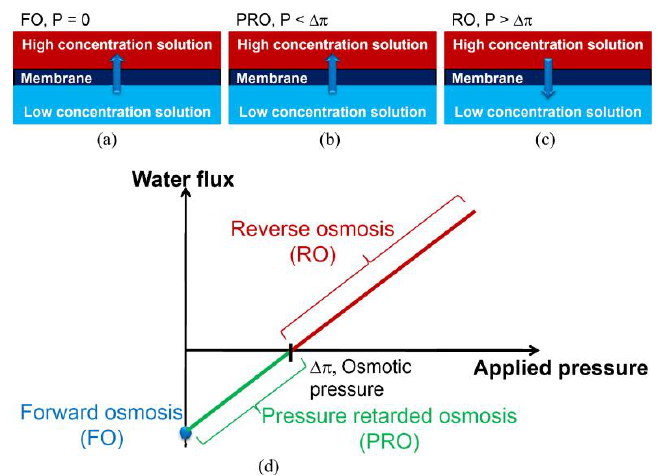
Figure 2. Illustration of FO, PRO, and RO processes: ( a ) FO process where no pressure is applied on the high concentration solution. Water flows from the low concentration side to the high concentration side; ( b ) PRO process where applied pressure on the high concentration solution is less than the osmotic pressure difference across the membrane. Water flows from the low concentration side to the high concentration side; ( c ) RO process where applied pressure on the high concentration solution is greater than the osmotic pressure difference across the membrane. Water flows from the high concentration side to the low concentration side; ( d ) Classification of FO, PRO, and RO in a flux versus pressure plot. Reprinted from [1,25,26], with permission from Elsevier.